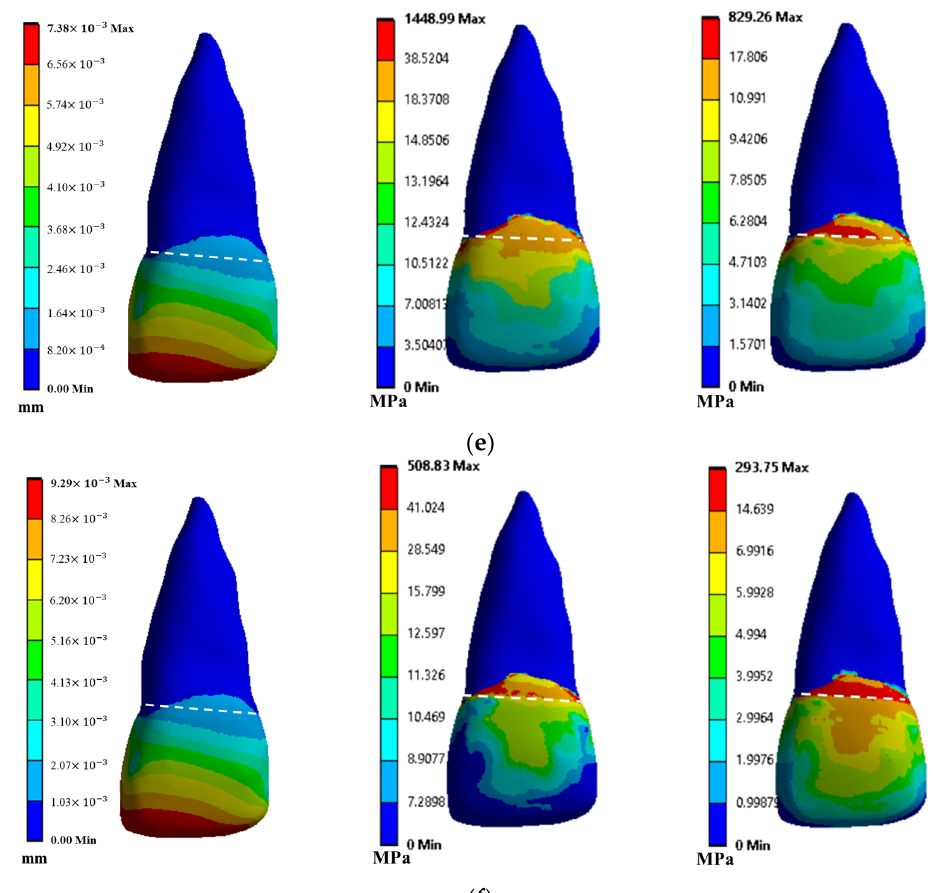
Figure 9. Displacement, stresses, and shear stresses across crown fracture: ( a ) masticatory loading in case of flowable composite, ( b ) masticatory loading in case of resin cement, ( c ) masticatory loading in case of resin adhesive, ( d ) traumatic loading in case of flowable composite, ( e ) traumatic loading in case of resin cement, and ( f ) traumatic loading in case of resin adhesive. The white dashed line in the figure represents the fracture line.